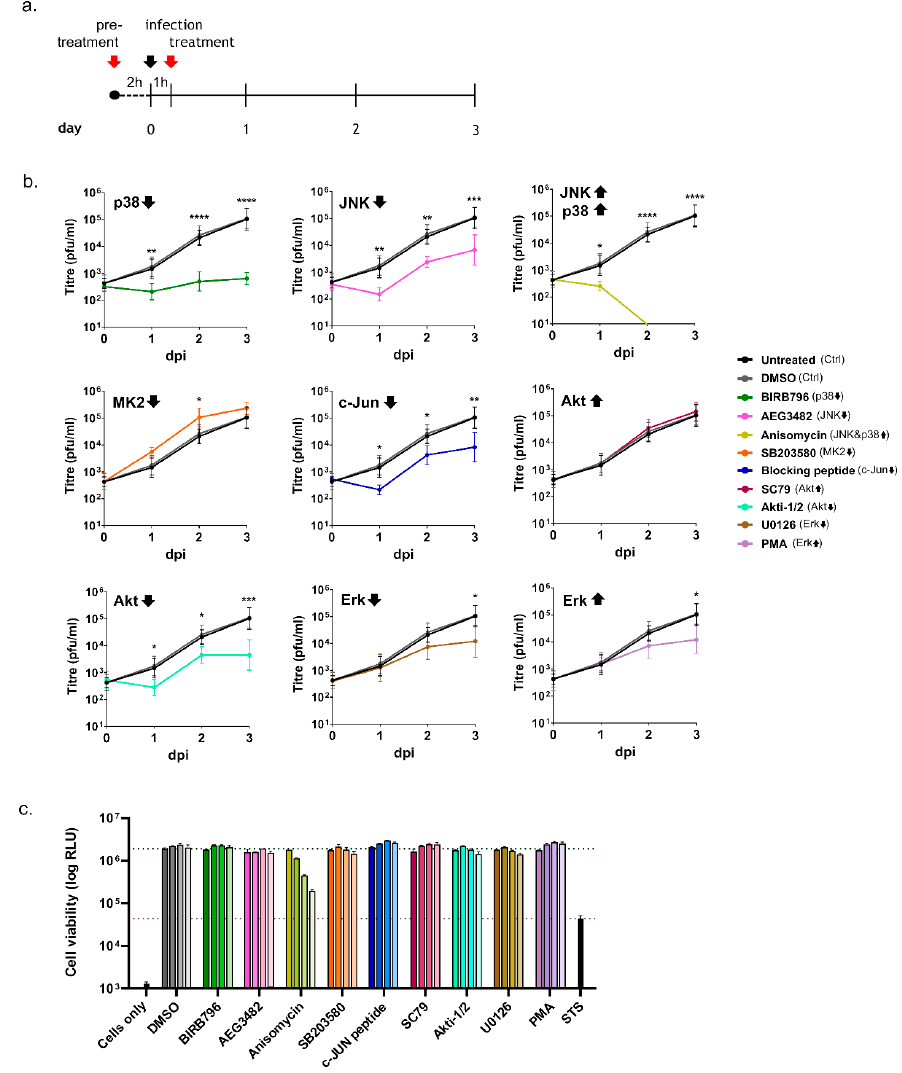
Figure 3. Influence of kinase inhibition or activation early in the infection on TCRV growth: ( a ) schematic timeline of the chemical treatment and infection procedure. Red arrows indicate the addition of drug dilutions and the black arrow indicates the start of the infection. Supernatants were harvested from day 0 to day 3 post infection; ( b ) virus growth. Vero76 cells were infected at MOI = 0.1 and treated with the indicated chemical compounds according to the scheme shown in ( a ). Samples were collected on days 0–3 post infection for analysis by plaque assay. Specific inhibitors for p38 (BIRB796; green), MK2 (SB203580; orange), Akt (Akti-1/2; turquoise), JNK (AEG3482; pink), c-Jun (c-Jun blocking peptide; blue) and Erk (U0126; brown), as well as specific activators for p38 and JNK (Anisomycin; dark yellow), Akt (SC79; magenta) and Erk (PMA; purple) were used. Infected untreated (black) and DMSO-treated (gray) cells served as controls. Statistical analysis was performed using two-way ANOVA (* p ≤ 0.05, ** p ≤ 0.01, *** p ≤ 0.001, **** p ≤ 0.0001). The data shown are the mean values and standard deviations from three independent experiments; and ( c ) cell viability assays. Cells treated with the indicated compounds were assessed for cell viability using the ATPlite 1step Luminescence Assay at the time points indicated in ( a ). The color code corresponds to that used for the different drugs in ( b ) with progressively lighter shades of the corresponding colors indicating the different time points, at which cell viability was measured (day 0 to day 3 post treatment). Black bars represent control cells that were either not incubated with the ATPlite reagent (cells only) or treated with 10 µ M STS to induce cell death as a positive control. The data shown represent means and standard deviations from two independent